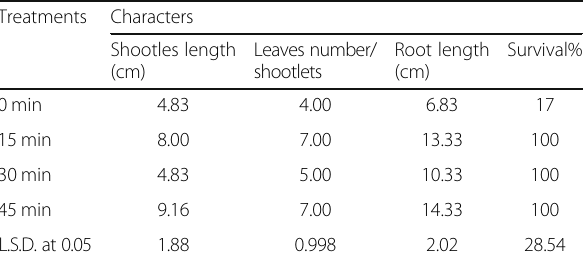
Table 1 Effect of UV-B radiation on morphological micropropagated of Spathyiphyllum cannifolium plant (mean of three subcultures) Treatments